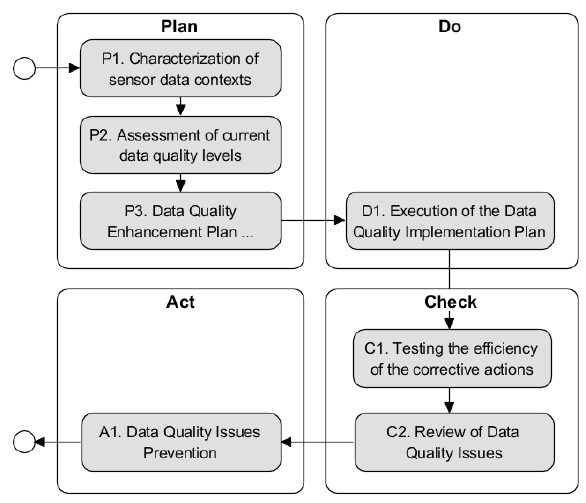
Figure 2. Methodology DAQUA-MASS phases and steps.